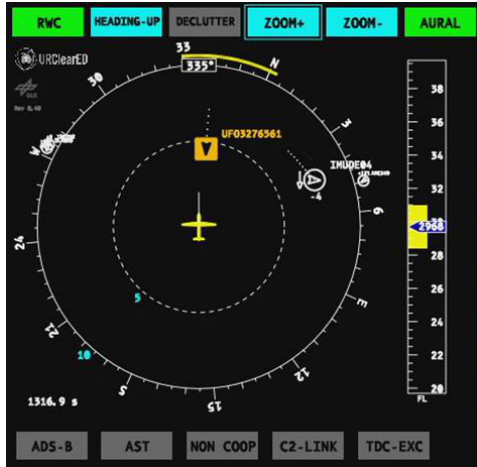
Figure 11. View of the CDTI displaying the surrounding traffic together with the alerting conditions, the horizontal and vertical conflict bands, and the overall status of the DAA RWC system.